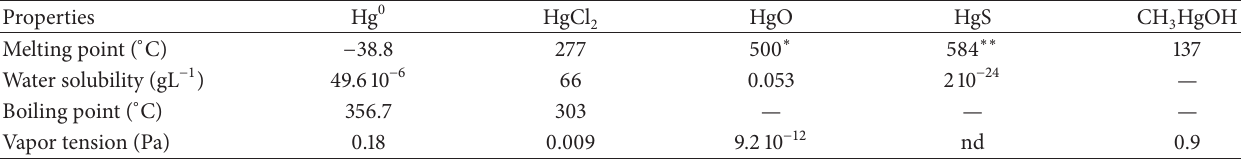
Table 1: Physicochemical properties of mercury and its compounds